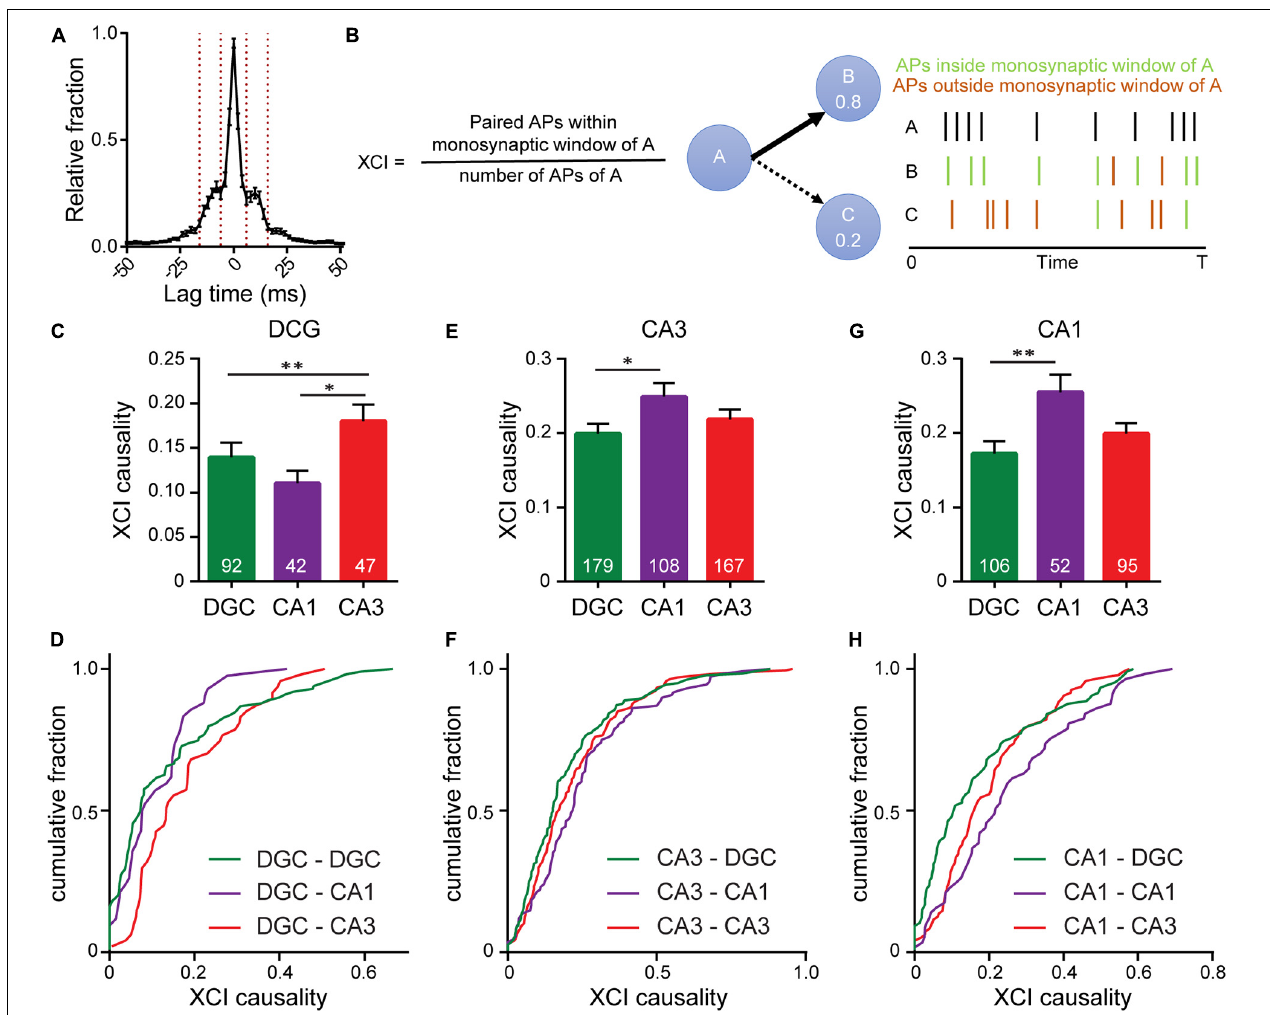
FIGURE 5 | Interrogating synaptic specificity in neuronal networks using voltage imaging. (A) Histogram of cross-correlation lag times between spikes in microisland cultures. Vertical lines highlight the 8–14 ms window we identified as a monosynaptic lag. (B) Schematic detailing XCI causality, a score of the strength of connection between neurons determined by comparing firing patterns of a template neuron with all excitatory neurons within the circuit. Bar plots of XCI causality and associated cumulative frequency plots showing connectivity strength between template neurons (indicated at the top of the graph) and other excitatory neurons in the same network at 15 DIV, where the template neurons are either DGCs (C,D) CA3 neurons (D–F) or CA1 neurons (G,H) . n indicated on graphs are numbers of neuron pairs analyzed. Data recorded from 42 microislands. Biological n is 4 experiments. Statistical tests are Kruskal-Wallis ANOVAs with multiple comparisons tests to all groups. ∗ p < 0.05, ∗∗ p <